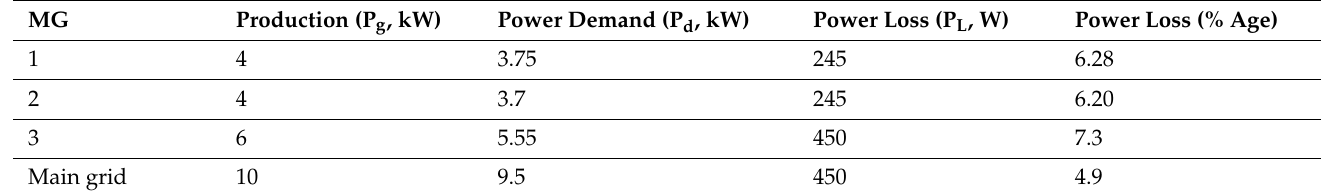
Table 8. Allocation of power and losses between MG1, MG2, MG3, and main grid in grid-tied mode.